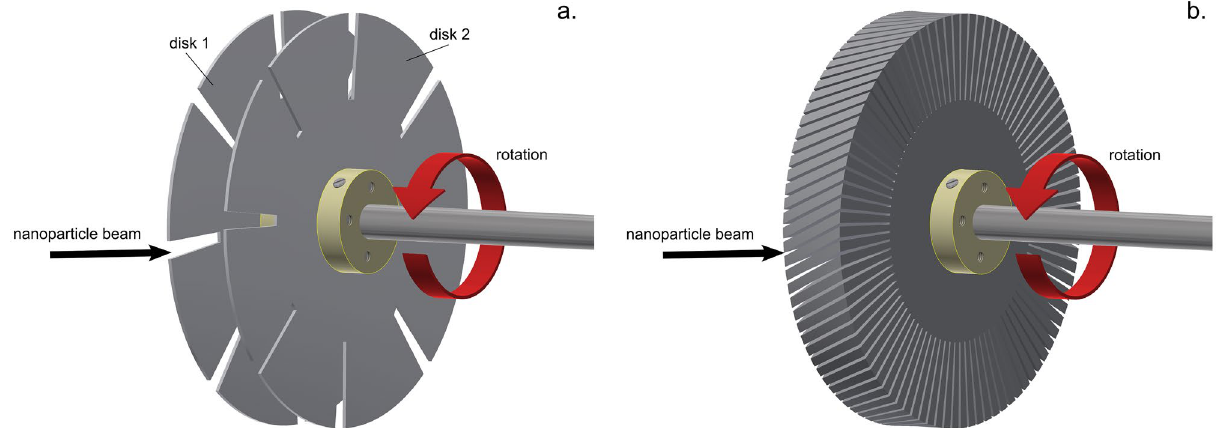
Figure 2. Schematics of the nanoparticle time-of-flight filter rotors: ( a ) slotted disks with 8 slits of angular width 5° on each disk. The relative angle between the disks is 9°, disks-to-disk distance is 19 mm, disk thickness is 1 mm; ( b ) helical rotor with 90 slits of angular width 1°, the relative angle between entrance and exit 9°, total thickness 20 mm and printing resolution 0.2